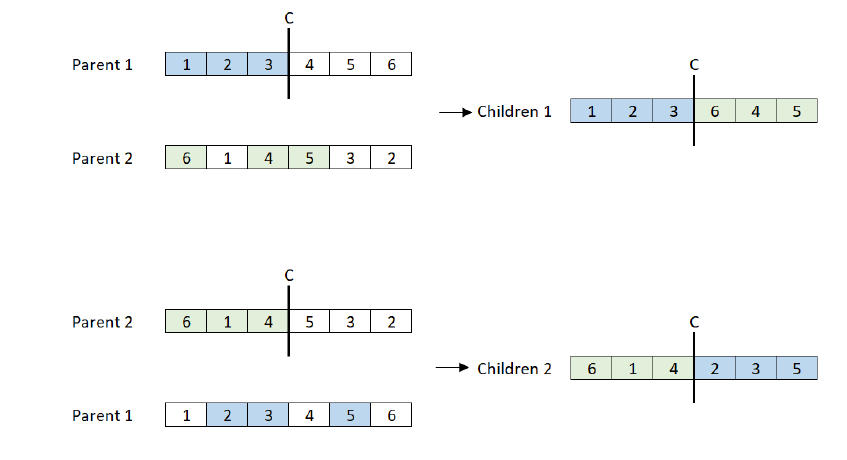
Fig. 3. Crossover representation. Made by the authors.